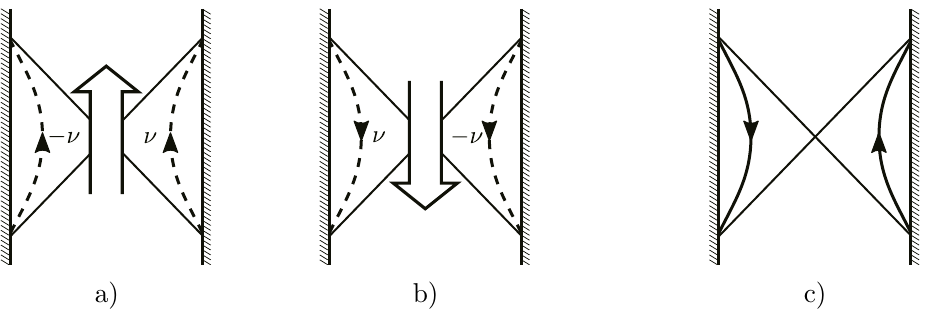
Figure 7 . a,b) The time with respect to which matter (cid:12)elds should be quantized, determined by the natural direction of propagation for (cid:23) - and ( (cid:0) (cid:23) )-particles on opposite sides of a classical trajectory; c) the direction corresponding to evolution by H TFD